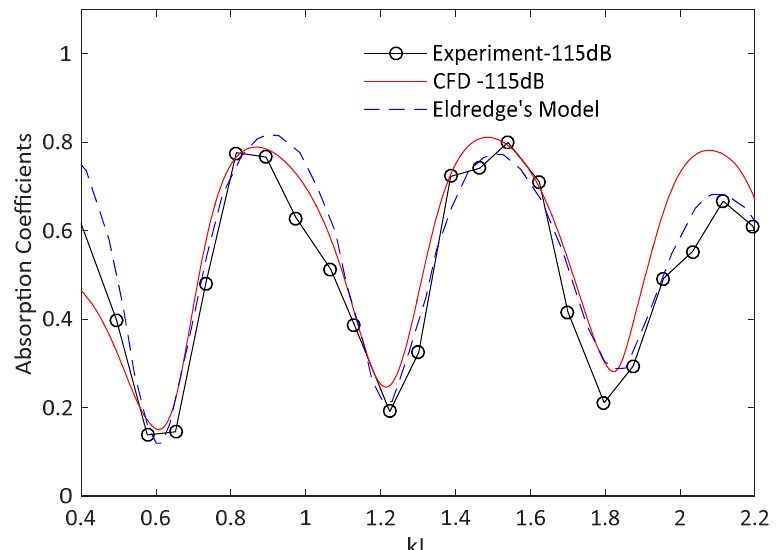
Figure 7. Numerical and experimental comparison of absorption coefficients at M in = 0.023 and zero grazing flow conditions [21].